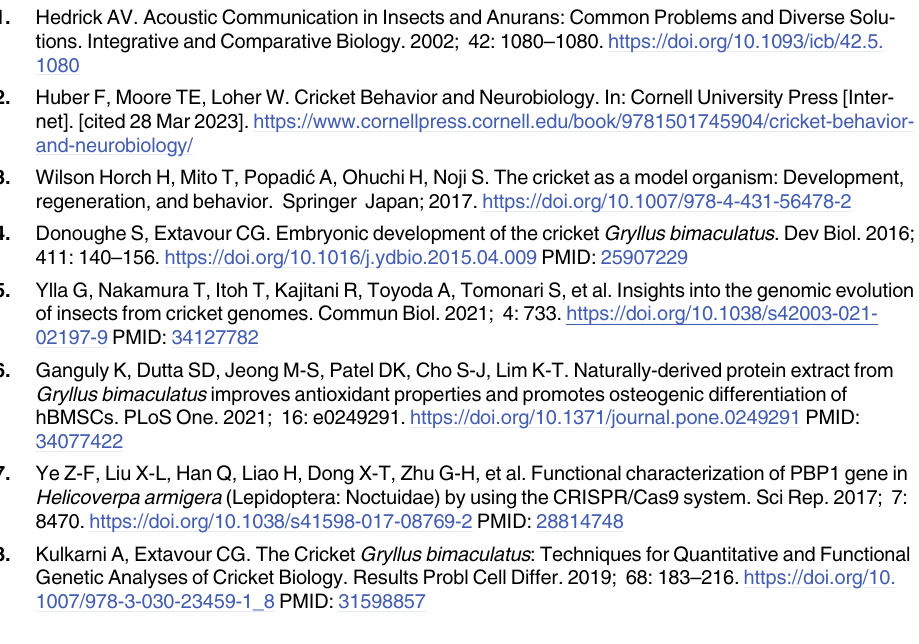
S2 Fig. DNA sequencing results of WT eggs and eggs injected with yellow-y sgRNA and Cas9 protein. The red box refers to the PAM sequence. S3 Fig. Phenotype and sequence analysis of TH gene mutants. The first strand is the wild type, and the second strand is the mutant. Bar = 3mm. (TIF) S4 Fig. (TIF) S1 Data.